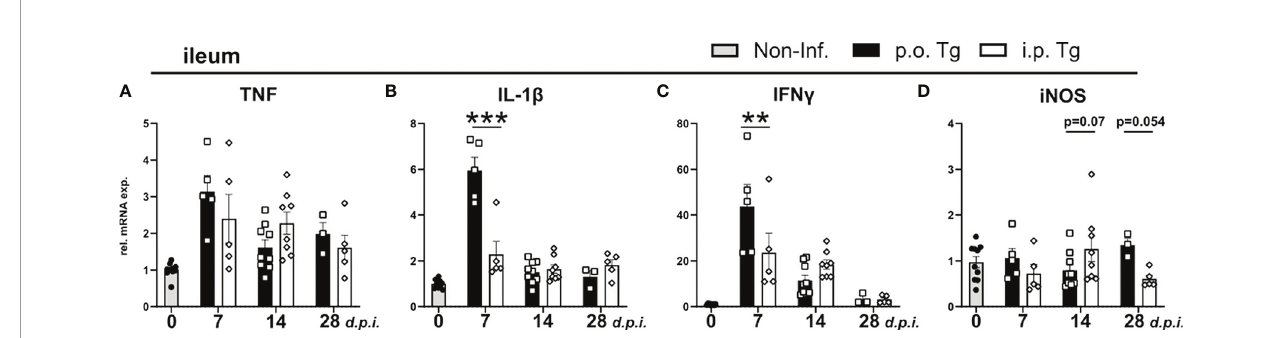
FIGURE 2 | Cytokine levels in the ileum in p.o. vs. i.p. infected mice on day 28 post-infection. Wild-type mice were infected orally ( p.o. Tg) or intraperitoneally ( i.p. Tg) with T. gondii (two cyst, ME49) and (A-D) relative mRNA levels of indicated genes were determined in the ileum. Data are normalized to the mean expression of the non-infected group and presented as mean ± SEM. A two-way ANOVA following Fisher ’ s LSD test was used for statistical analysis (**p<0.01, ***p <